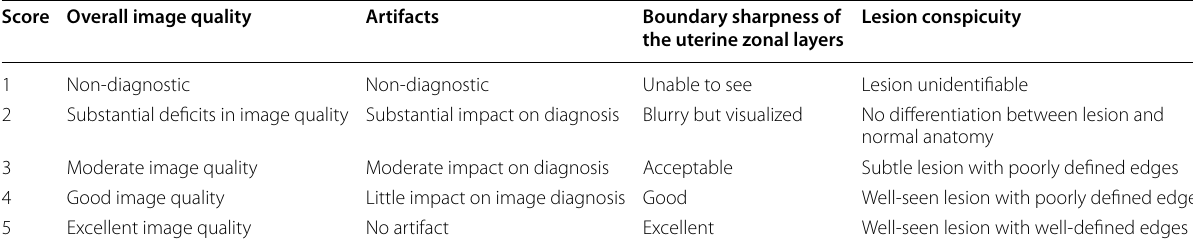
Table 3 Qualitative image evaluations based on the 5‑point Likert